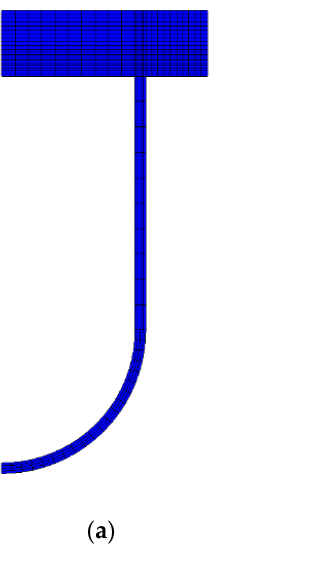
Figure 10. ( a , b ): View of a sector of 2D ( a ) and 3D ( b ) FE models.